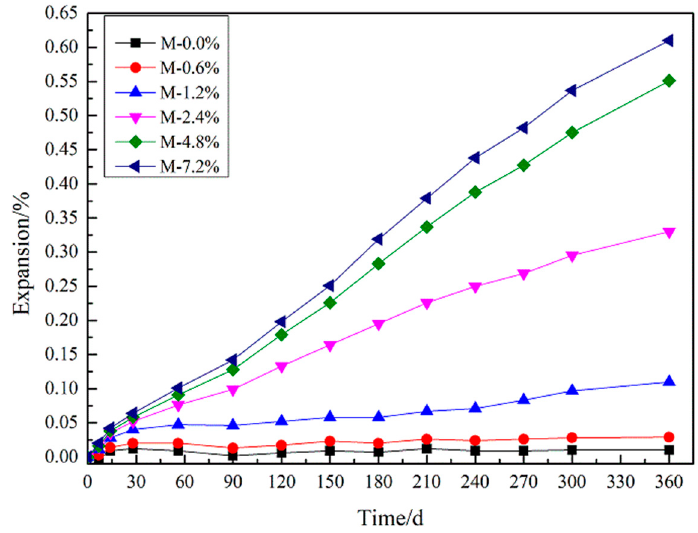
Figure 10. Expansion of mortars with different SO 3 content in aggregate.